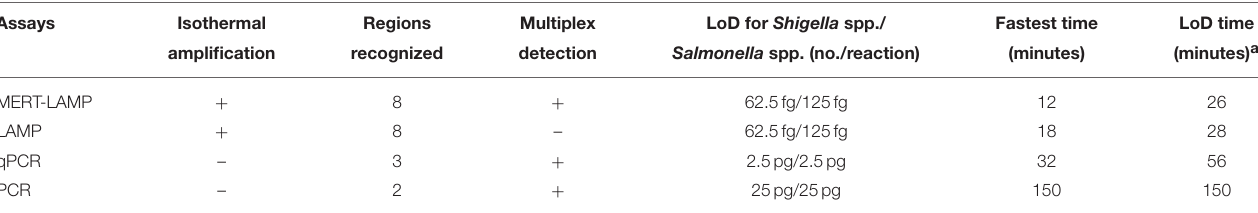
TABLE 3 | The LoD and time for single MERT-LAMP targeting ipaH and invA genes compared with that of qPCR and conventional PCR approaches. Assays Isothermal Regions Multiplex LoD for Shigella spp./ Fastest time LoD time amplification recognized detection Salmonella spp. (no./reaction) (minutes) (minutes) a 8